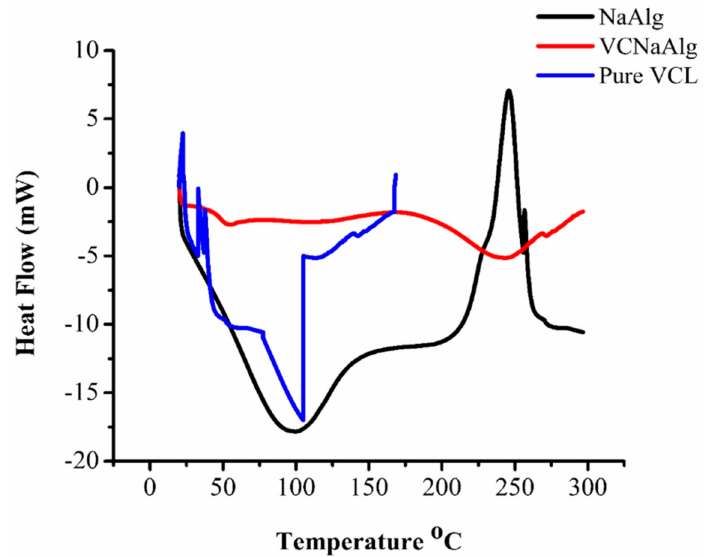
Figure 3. DSC analysis of pure NVCL, pure NaAlg, and bare chemically grafted Poly (NVCL- g -NaAlg) in situ depot gel